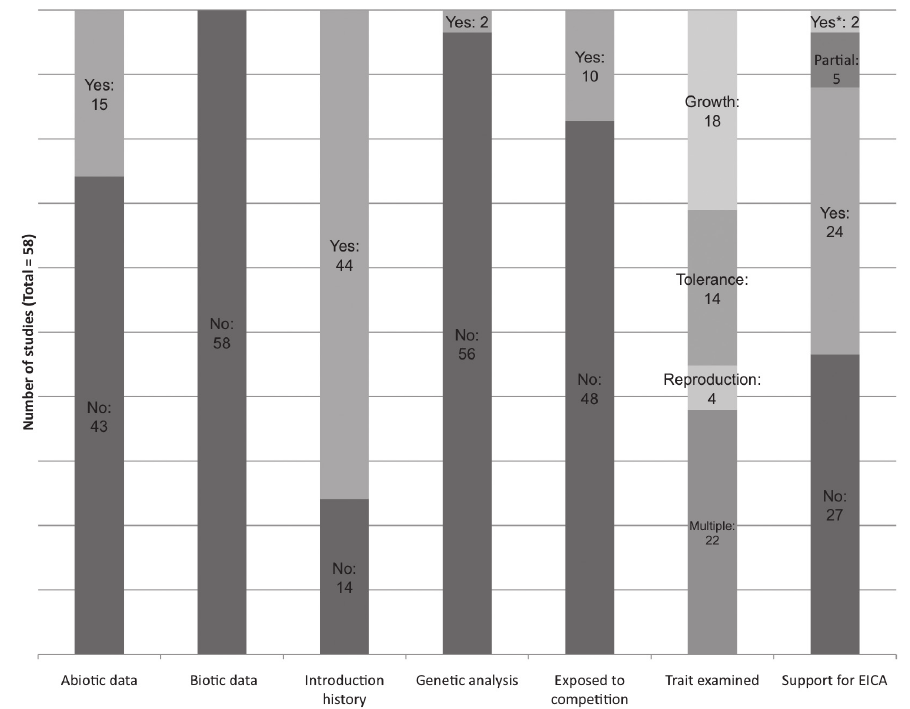
Figure 1. Frequencies of methodologies used in EICA studies. Data are aggregated from our review of design parameters detailed in Table 2. “*” Indicates that support for the EICA hypothesis was found only when plants were grown in the absence of